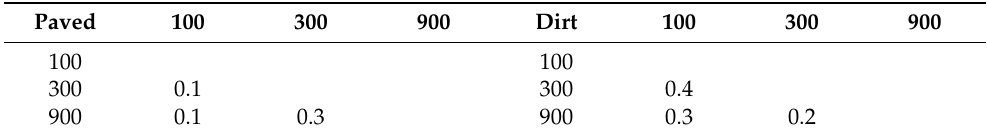
Table 3. The Jaccard distance comparing the plant communities for their species composition at the three distances from the paved and dirt